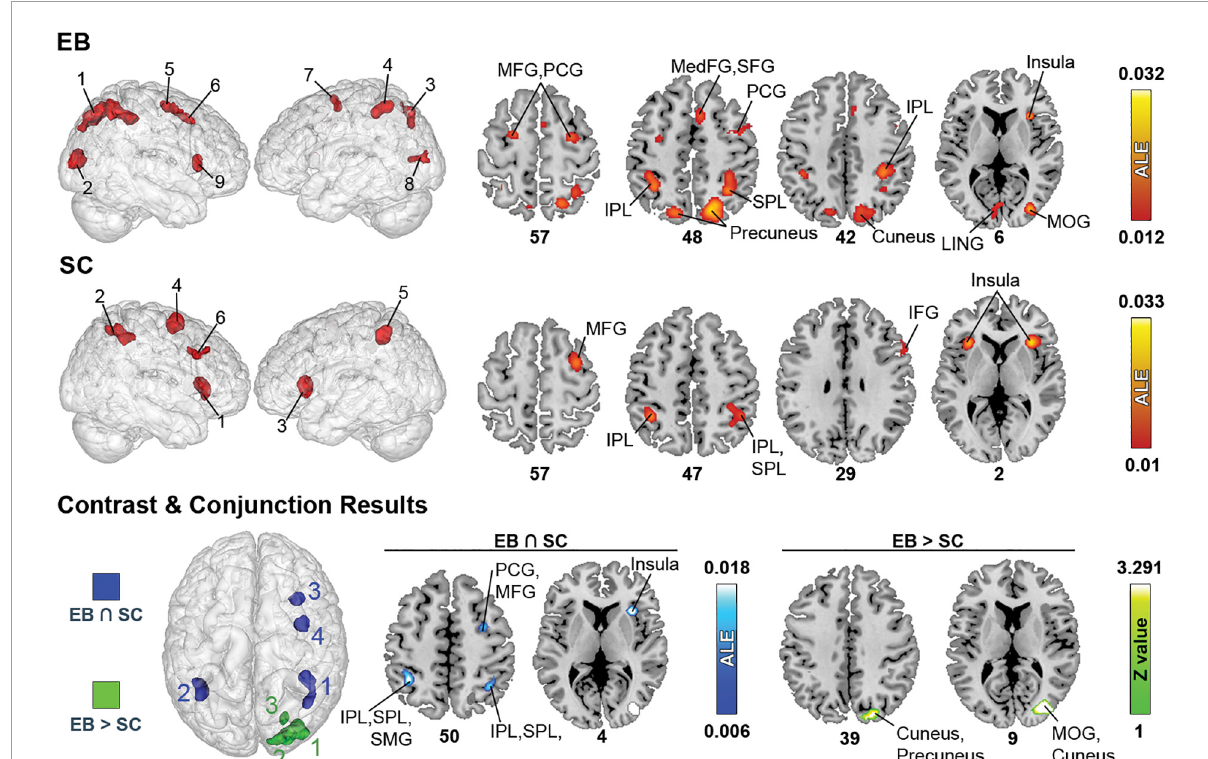
FIGURE4 Brain areas activated in spatial processing + spatial navigation in EB, LB, and SC and results of contrast and conjunction analyses. (Left) 3D renders of the brain and activation clusters (see Table 4 for reference). (Right) Axial cuts of the brain with identified clusters of activation. The number below the slices refer to the z coordinate in MNI space. ALE (for single and conjunction meta-analyses) and Z values (for contrast meta-analyses) are displayed to the right. The ALE values, calculated for each voxel, represent the probability of activation across included studies (Turkeltaub et al., 2012). For the contrast analysis, Z-values are used to show the significance of ALE subtractions between two groups. More details regarding the ALE and Z values are presented in Table 5 . IOG, inferior occipital gyrus; IPL, inferior parietal lobule; ITG,